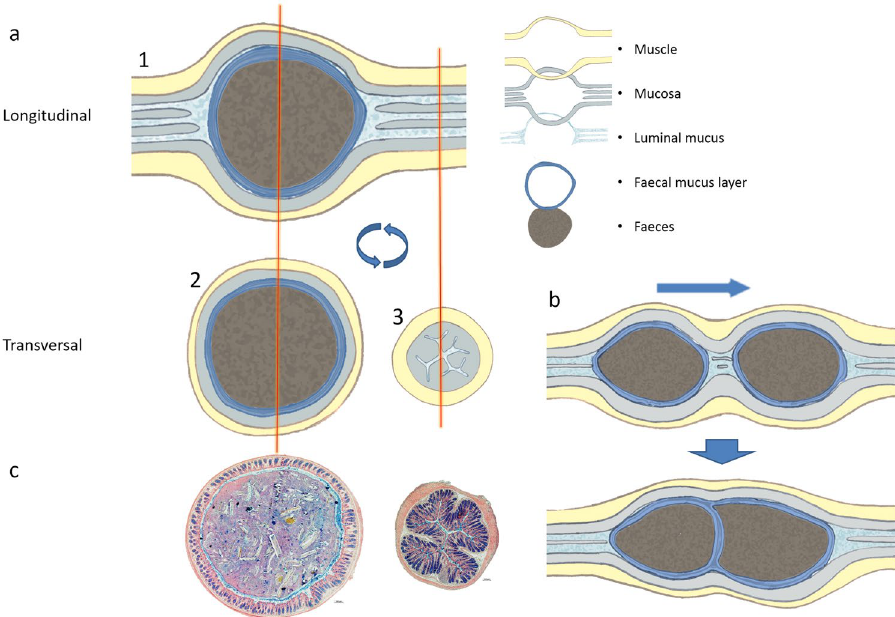
Figure 9. Schematic overview of mucus organisation situations as observed in different sections. ( a1 ) In longitudinal sections the mucus layer is found attached to the faecal pellet. ( a2 ) In transversal sections, we see the firm mucus layer around the faeces in sections containing faeces. ( a3 ) This cannot be observed in transversally sectioned empty colon. ( b ) Further evidence of adherence of the mucus layer to the faecal pellet is provided by the internalisation of the sterile mucus layer inside faecal pellets by collisions between pellets; an observation which can not be explained in the classical model of mucus organisation in which the observed mucus layer is attached to the epithelium. Additionally, the observation of the same mucus layer covering expelled faecal pellets (Fig. 6) indicates clearly that this mucus layer covers the faeces. ( c ) AB/H/E stained sections of full and empty mouse distal colon corresponding to the schematic overview of ( a